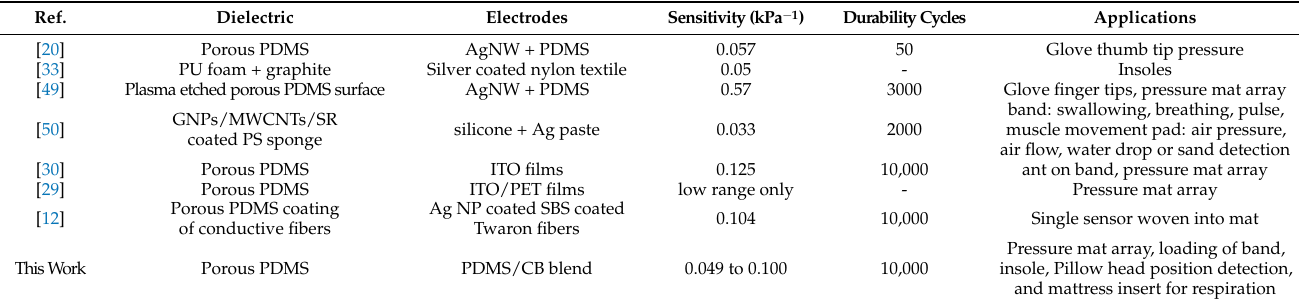
Table 2. Summary of porous silicone dielectric based capacitive pressure sensors, and a notable polyurethane (PU) foam based sensor. Approximate sensitivity values are given for the 10 kPa range. Many of these sensors display much higher sensitivity in the range below ~2 kPa. Abbreviations: GNP—graphene nanoplatelets; SR—silicone rubber.